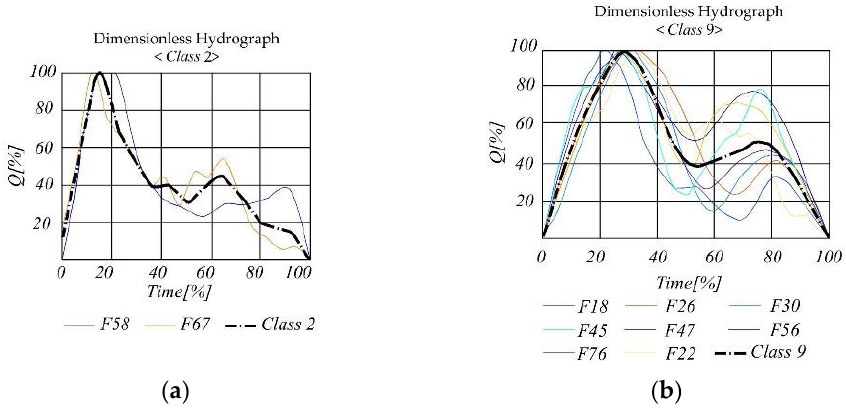
Figure 4. Examples of average dimensionless floods: ( a ) Class 2; ( b ) Class 9.